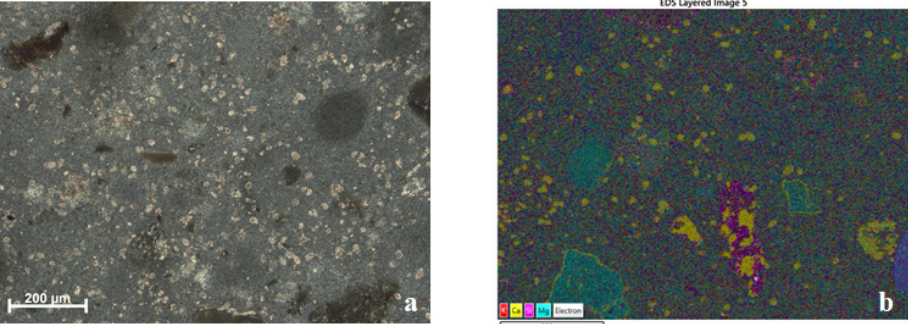
Figure 4. Microphotographs of high birefringence and dark areas in the binder of an air hardening magnesian lime belonging to a mortar of the core of the masonry of a bastion of the 14th century city walls of Genoa under ( a ) PLM, xpl, and ( b ) SEM EDS layered map of K, Ca, Mg, and Si. Table 3. Microchemical spot analyses (GP1–GP7) of high birefringence and dark areas of air hard- ening magnesian lime of Figure 4.